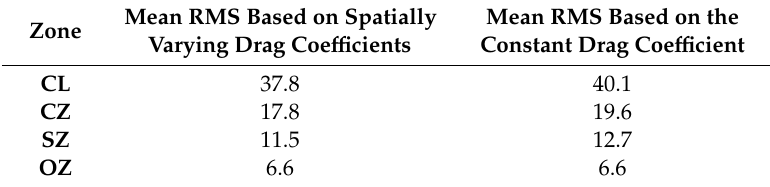
Table 5. The role of drag coefficient values—mean RMS errors of SLA differences (cm). Zone